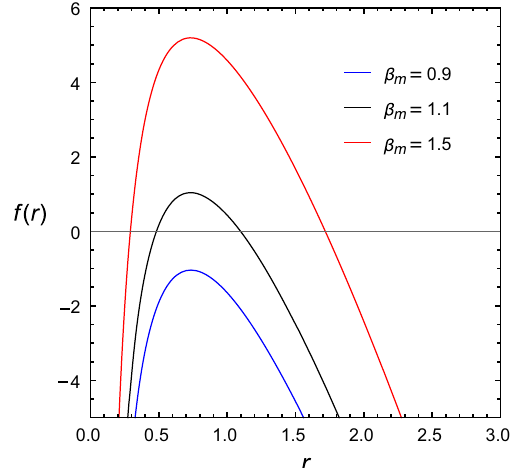
Fig. 1 Plot of f ( r ) using different values of β m , with M = 1 and c 2 = −